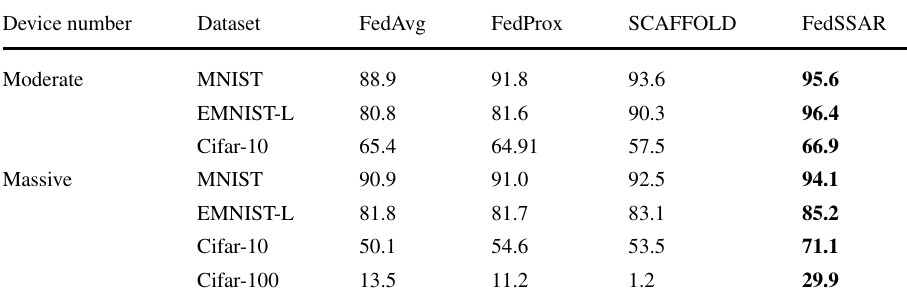
Bold represents the best experiment